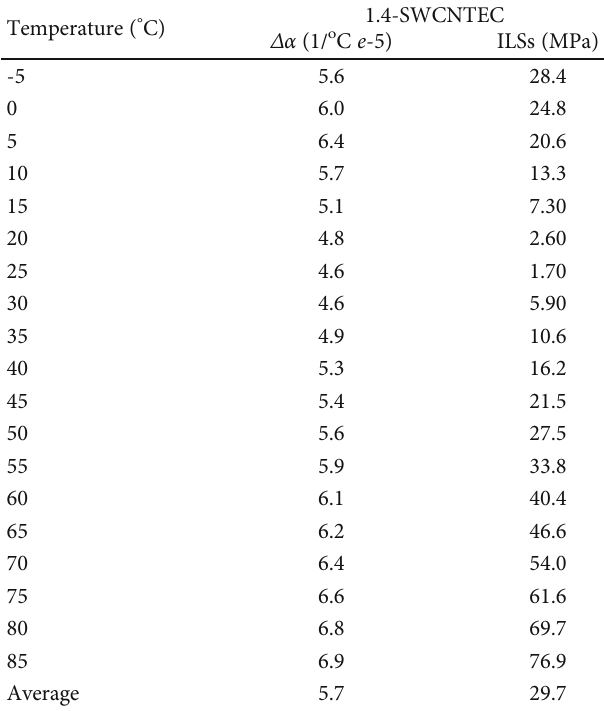
Table 1: Mismatches between the CTEs of 1.4-SWCNT and epoxy ( Δα ) and ILSs at a temperature range of -5 to 85 ° C within